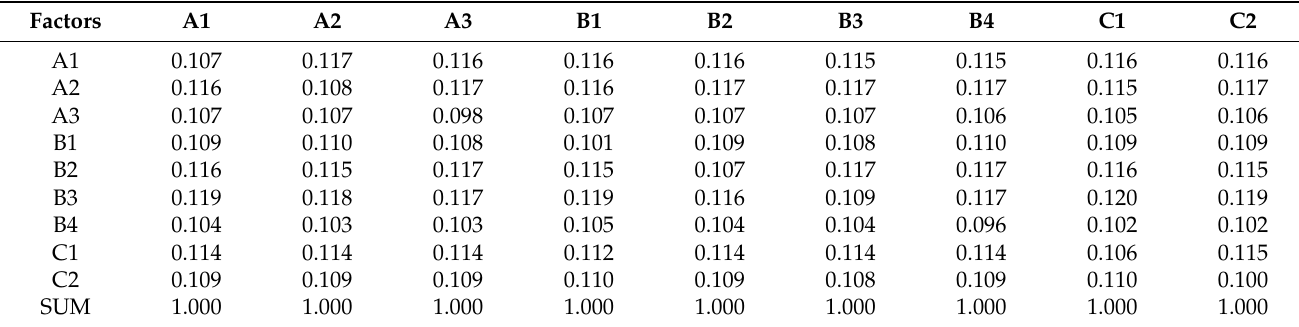
Table 6. Weighted Supermatrix